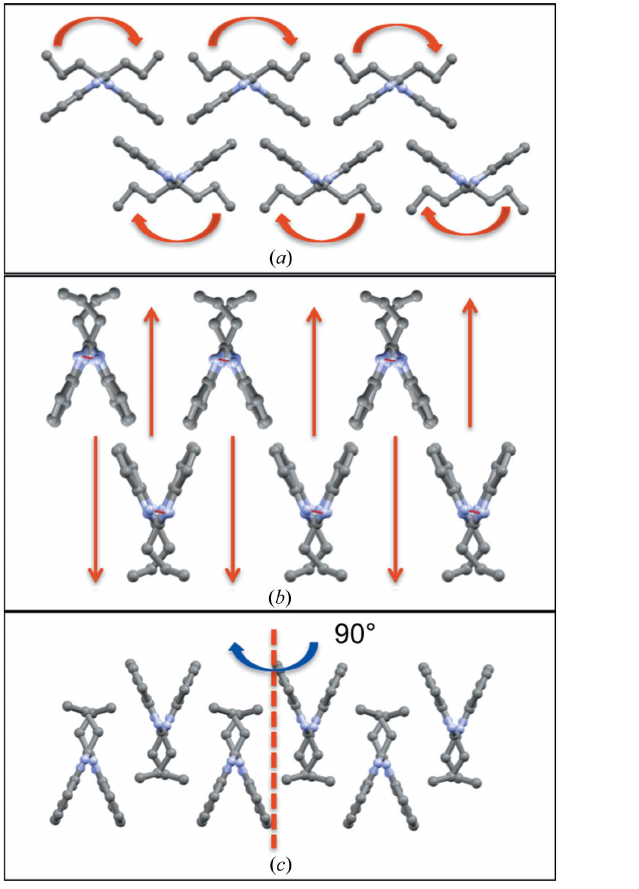
Figure 12 View along the hydrogen-bonded axis of form II phases at HT, RTand LT. Hydrogen atoms have been omitted for clarity.